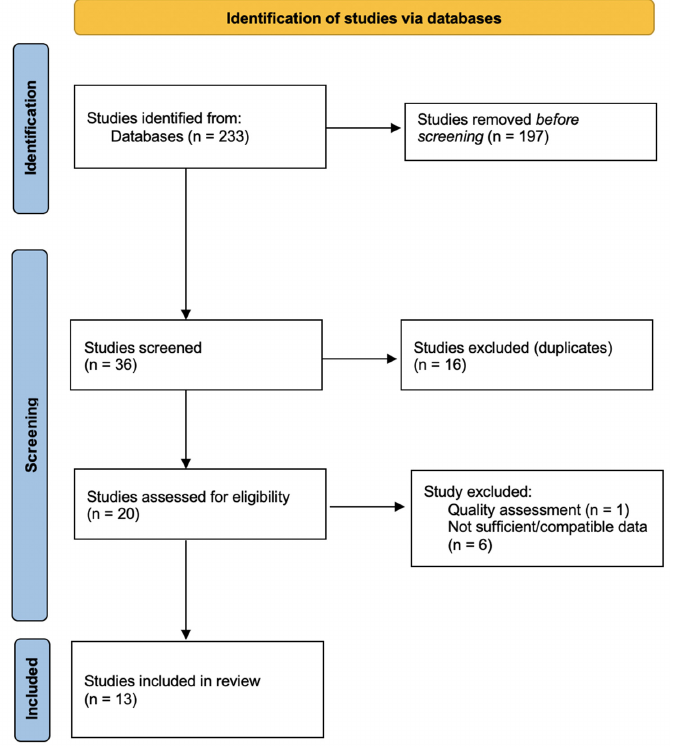
Figure 1. PRISMA Figure 1. PRISMA Flowchart. Table 1 . Study Characteristics .